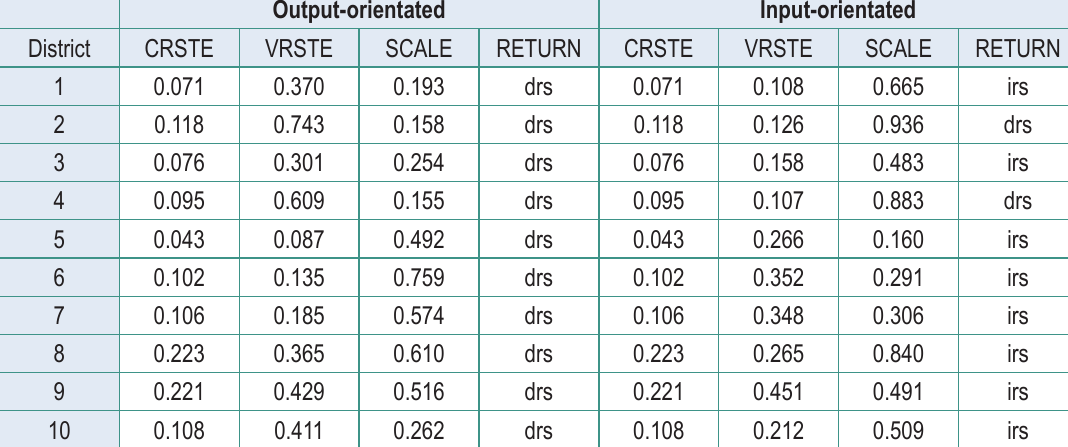
Table 1: Relative Efficiency Estimates for District Municipalities